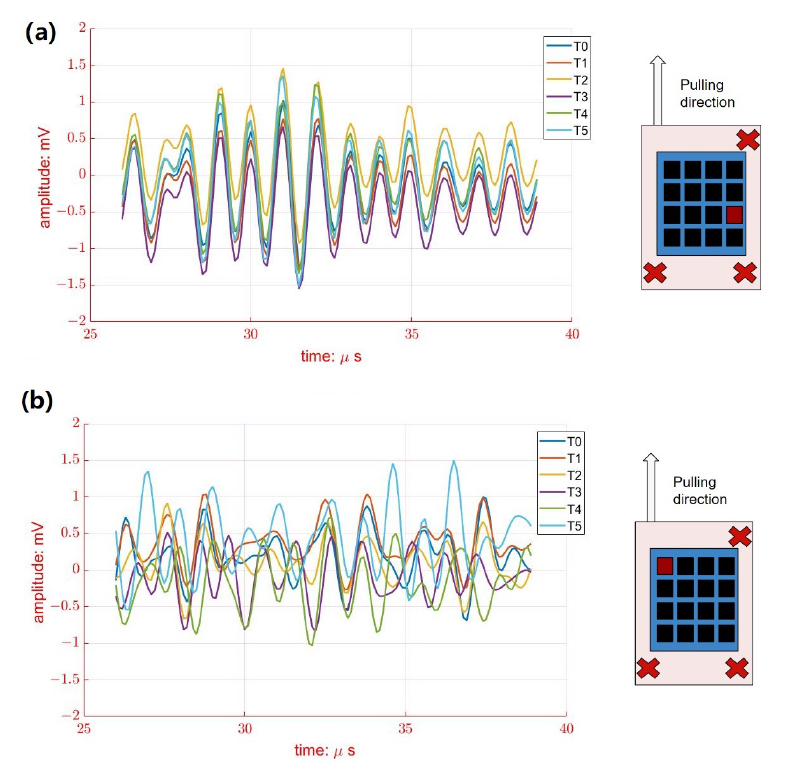
Figure 8. The variations of received RF signals from porcine tissue#1 at different pulling distances from T0 to T5 from ( a ) element #2 and ( b ) element #16. The location of selected elements is marked in